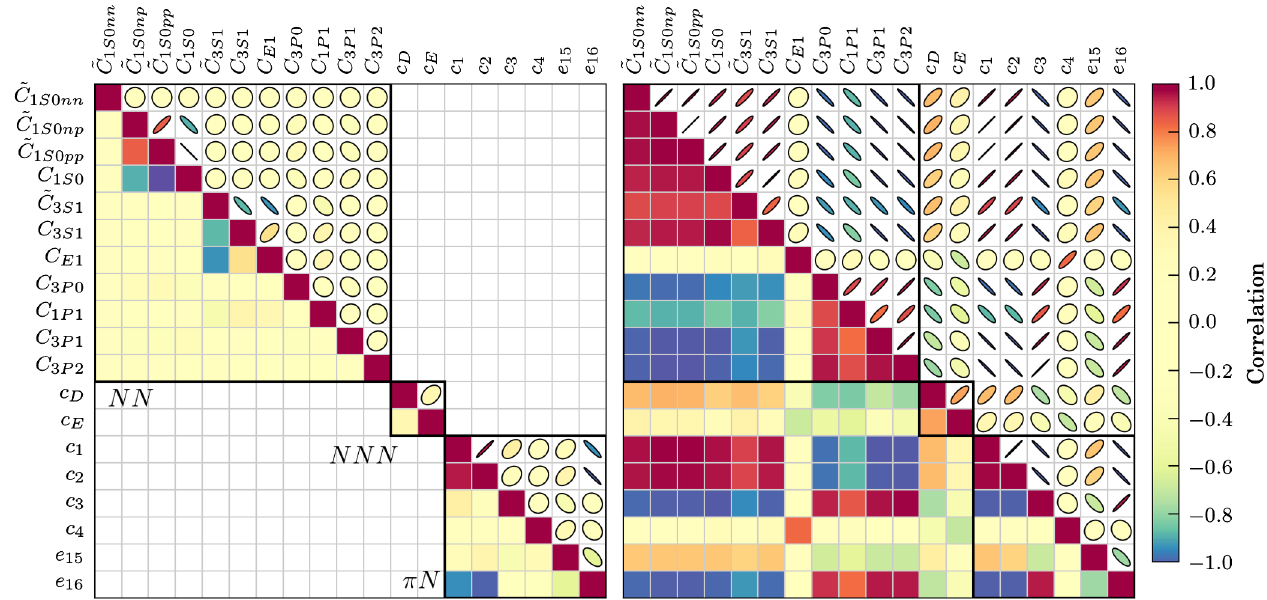
FIG. 6. Graphical representation of the linear correlation matrix for NNLOsep (left panel) and NNLOsim (right panel) including selected LECs. The separately optimized NNLOsep potential does not probe the statistical correlation between LECs entering different optimization stages. It is striking that there are almost no correlations for the NNLOsep potential, while for the NNLOsim potential the situation is quite the